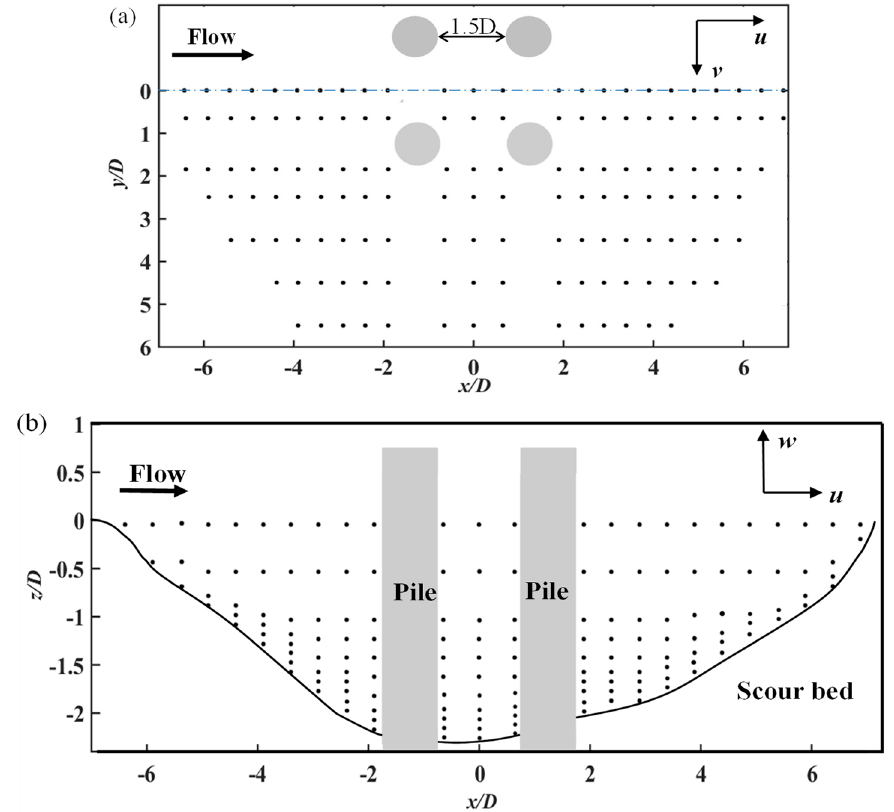
Figure 3. Measurement grid of ADV: ( a ) locations of measurement points in horizontal planes of z / D = 0; ( b ) locations of measurement points at vertical section of y / D = 0.